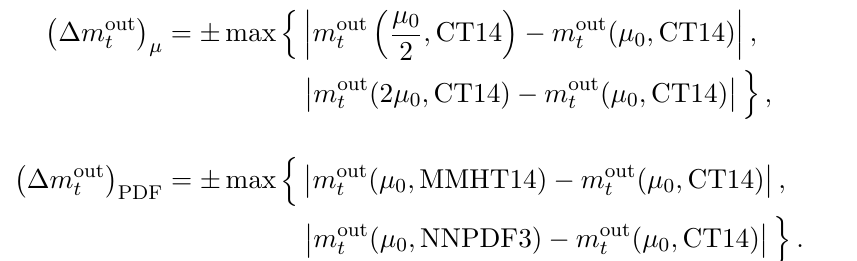
Figure 8 . Representative ~ (cid:31) 2 ( (cid:31) 2 =d:o:f: ) for the normalised (cid:26) s observable for the pp (cid:17) e + (cid:23) e (cid:22) (cid:0) (cid:22) (cid:23) (cid:22) b (cid:22) bj + X production process at the LHC with p s = 13 TeV. The binning of ATLAS and CMS is used. Luminosity of = 2 : 5 fb (cid:0) 1 and = 25 fb (cid:0) 1 is assumed and f i ( m t ) are obtained L L from the full theory at NLO in QCD with (cid:22) R = (cid:22) F = (cid:22) 0 = H T = 2 and with the CT14 PDF set. For each case, the (cid:31) 2 distribution is calculated and the corresponding top quark